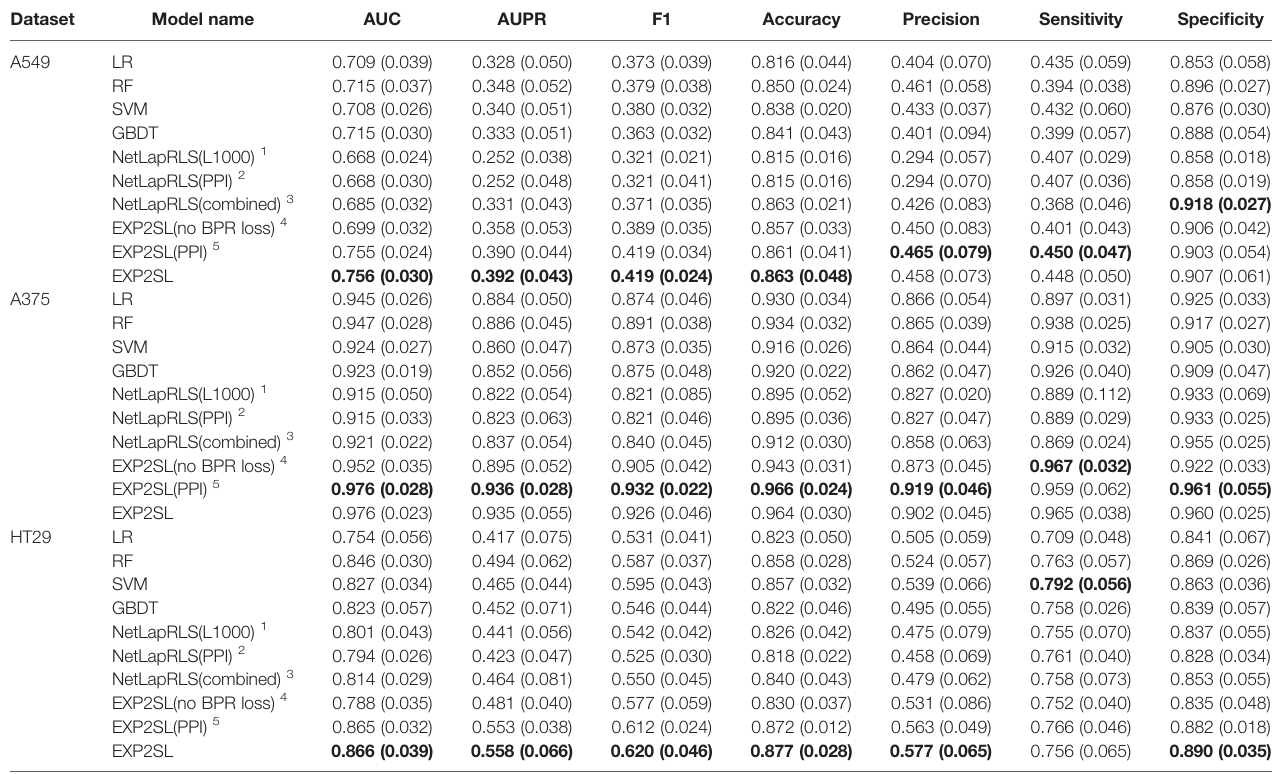
TABLE 3 | Performance evaluation in three different cell lines under the “ split gene ” setting. The mean and standard deviation (in brackets) of metrics over 10 repeats of 5-fold cross-validations are shown. The best results for each cell line and each metric are marked in bold.